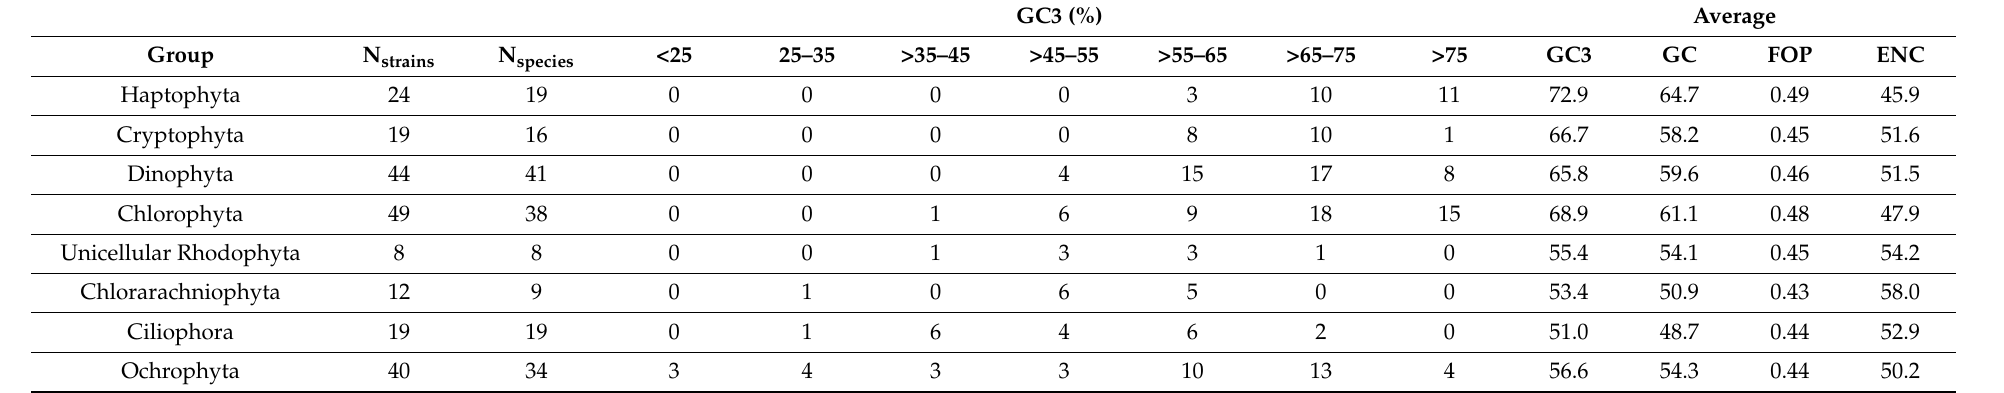
Table 1. Distribution of GC content at the 3rd codon position (GC3) and average codon bias statistics for eight phytoplankton groups. Data are provided in Table